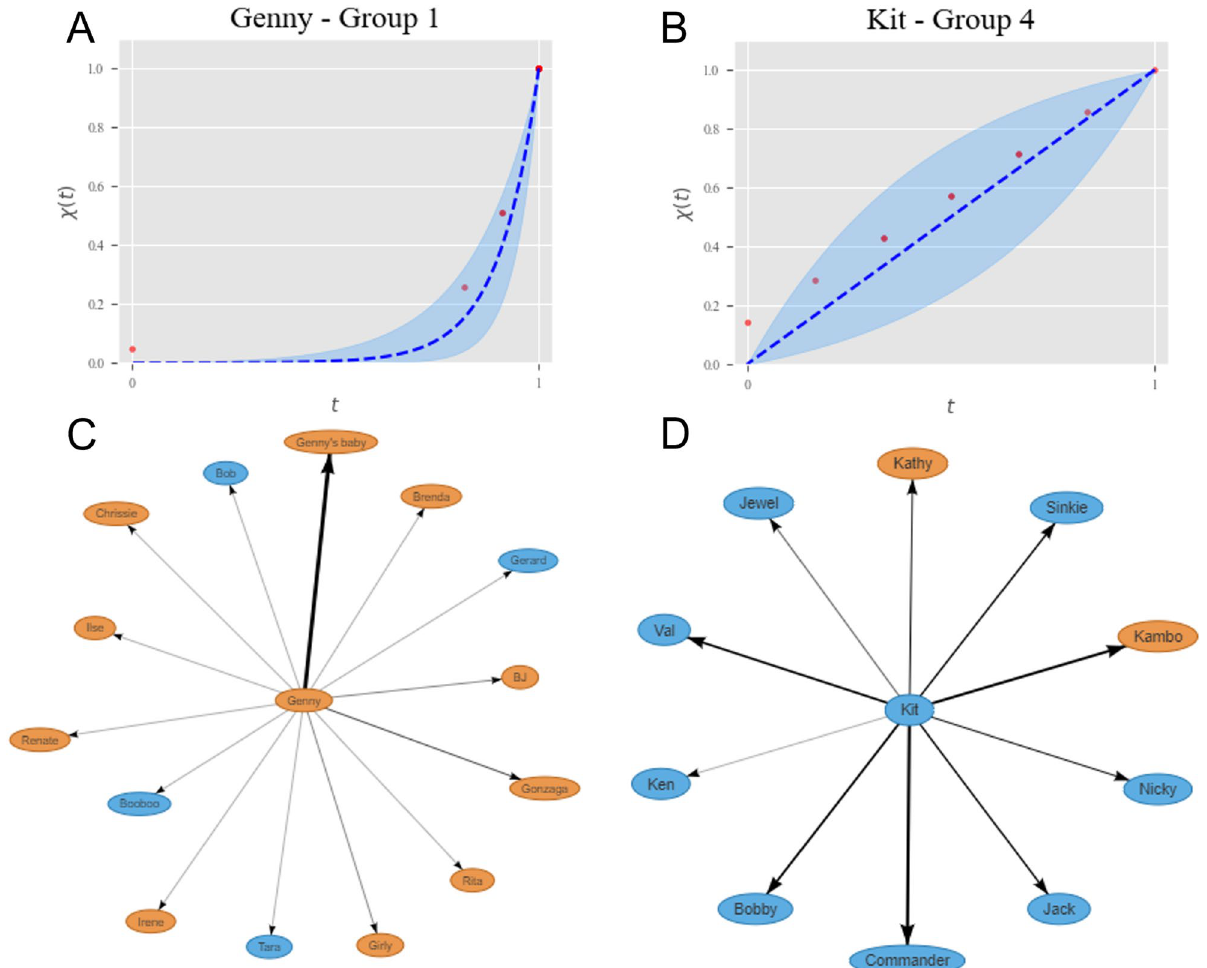
Figure 3. Examples of the relationship between the η parameter and the proportion of relationships of different intensity. χ( t ) functions and egonetworks for Genny (Group 1 and η = 10.3 ) and Kit (Group 4 and η = 0.14 ). Arrows connect the focal individual with those it grooms, while the width of the arrows represents the total amount of time devoted to grooming a specific chimpanzee. Orange ovals represent females, blue ones represent